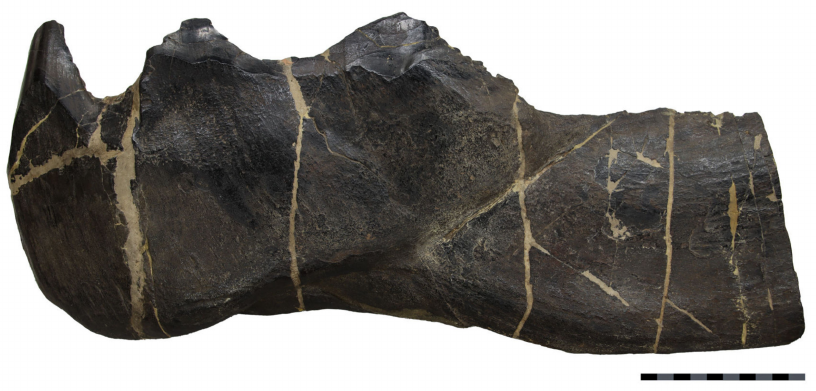
Figure 9. CMNH 5936, a left inferognathal fragment pertaining to the largest currently known individual of Dunkleosteus terrelli . Scale = 10